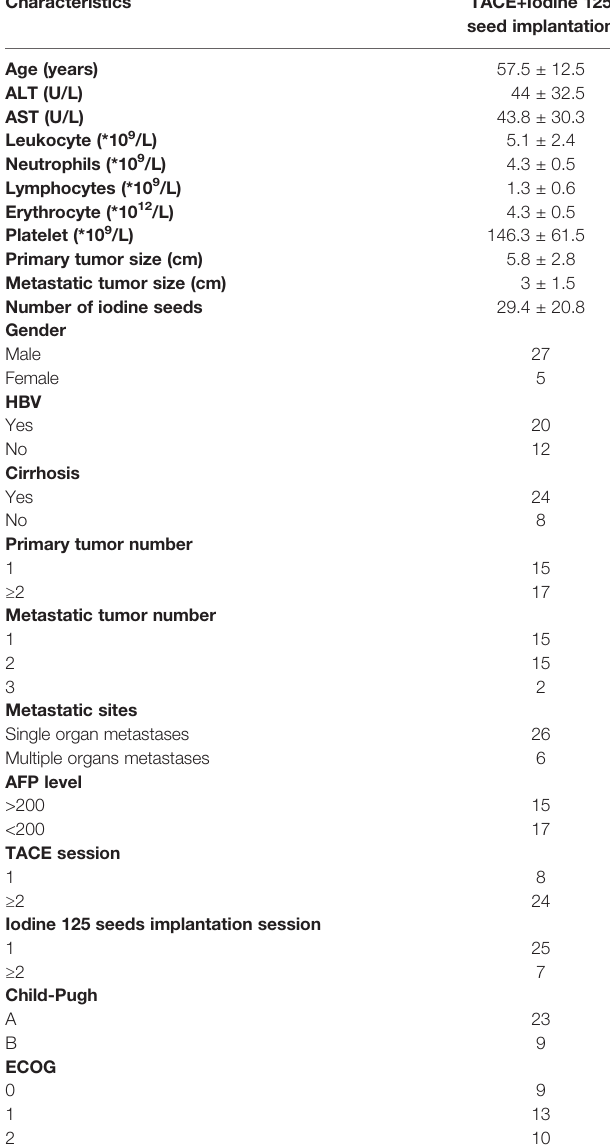
TABLE 1 | The baseline characteristics of patients with